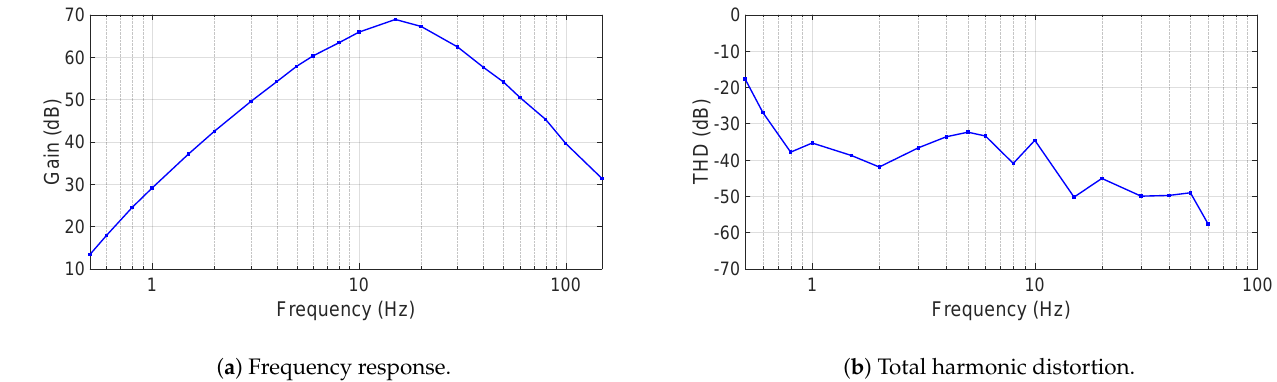
Figure 5. The device’s frequency response and total harmonic distortion.